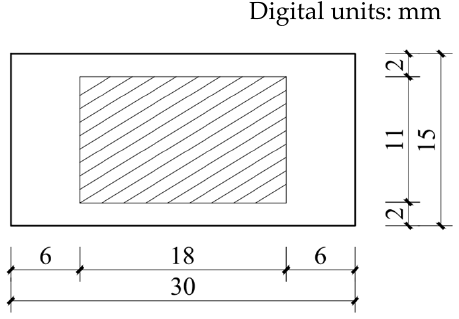
Figure 7. Cutting depth of the single-seam cracking specimen.